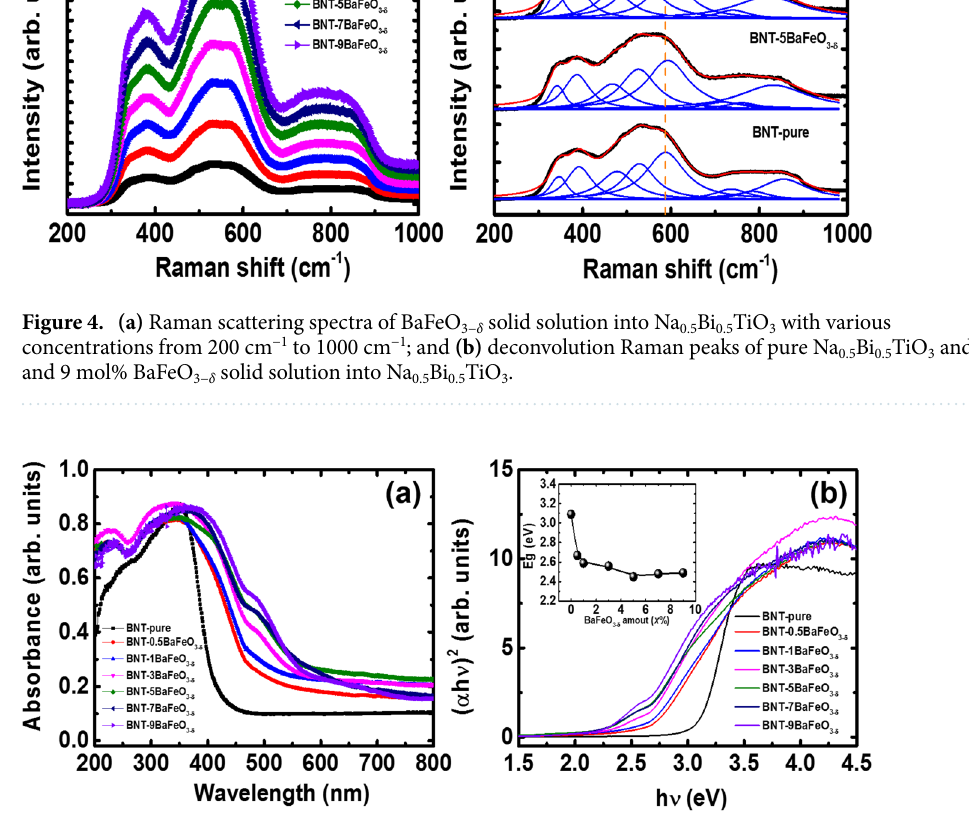
246–401 cm −1 are dominated by TiO 6 vibrations, and the higher frequency modes in the range 413–826 cm −1 are in overlap of Raman scattering peaks in range of 109–134 cm −1 and 155–187 cm −1 , which were originated from Bi-O and Na–O vibration modes, respectively 53 . In addition, Chen et al. reported that the vibration of Ti–O bonds is related to the wave number in range of 200–400 cm −1 while the vibration of TiO 6 octahedra is assigned to the wave number regions from 450 cm −1 to 700 cm −154 . The overlapping of Raman scattering modes was hard to characterize the influence of Ba and Fe into vibration modes of host lattice Na 0.5 Bi 0.5 TiO 3 materials. Therefore, we tried to distinguish the Raman scattering modes via the fitting with Lorentz functions (with correction of fitting over 0.99). The deconvolution Raman scattering modes (blue line) of pure Na 0.5 Bi 0.5 TiO 3 samples and BaFeO 3−δ -modified Na 0.5 Bi 0.5 TiO 3 samples with example for 5 and 9 mol% BaFeO 3−δ , as shown in Fig. 4b. The eight Raman scattering vibrational modes were obtained for both pure Na 0.5 Bi 0.5 TiO 3 and BaFeO 3−δ -modified Na 0.5 Bi 0.5 TiO 3 samples. The results were well consistent with recently observation in vibration of Raman scatter- ing modes of perovskite-type structural Ae FeO 3−δ family-modified Na 0.5 Bi 0.5 TiO 3 materials 28–30 . The vibration modes at around 595 cm −1 (red dot line marked in the Fig. 4b) trended to shift to high frequency, which were suggested to be related to distorted structure of (Ti,Fe)O 6 framework and/or effective mass effect because of difference between the radius and mass of impurities Fe and host Ti at B -site 28–30 . In other word, the shifted Raman scattering modes confirmed the substitution of Ba and Fe into the host lattice of Na 0.5 Bi 0.5 TiO 3 materials. Figure 5a shows the optical absorption spectra of pure Na 0.5 Bi 0.5 TiO 3 and BaFeO 3−δ -modified Na 0.5 Bi 0.5 TiO 3 with various BaFeO 3−δ concentrations. Pure Na 0.5 Bi 0.5 TiO 3 samples exhibited a single absorbance edge, consist- ent with the reported optical properties of Na 0.5 Bi 0.5 TiO 3 materials 9–11,55 . However, pure Na 0.5 Bi 0.5 TiO 3 materials